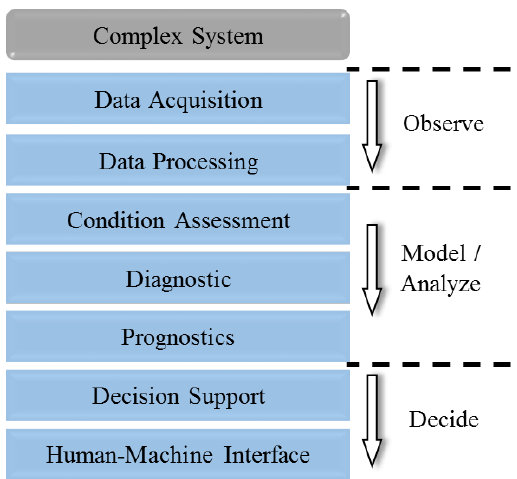
Figure 1. Prognostics and health management (PHM) architecture.